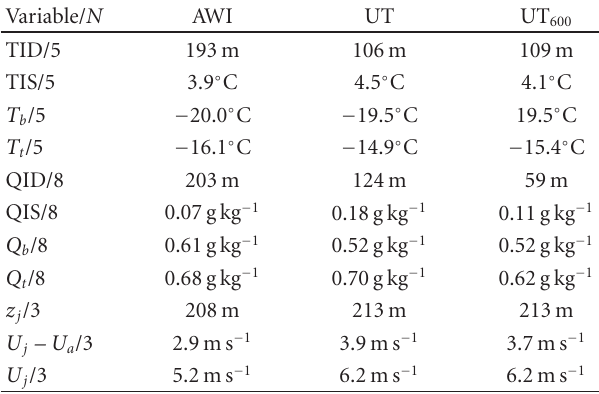
Table 2: Comparison of simultaneous soundings by AWI and UT. UT 600 refers to the inversion statistics based solely on the lowermost 600 m of the UT data. N denotes the number of simultaneous obser- vations for each variable. See Section 3 for definition of